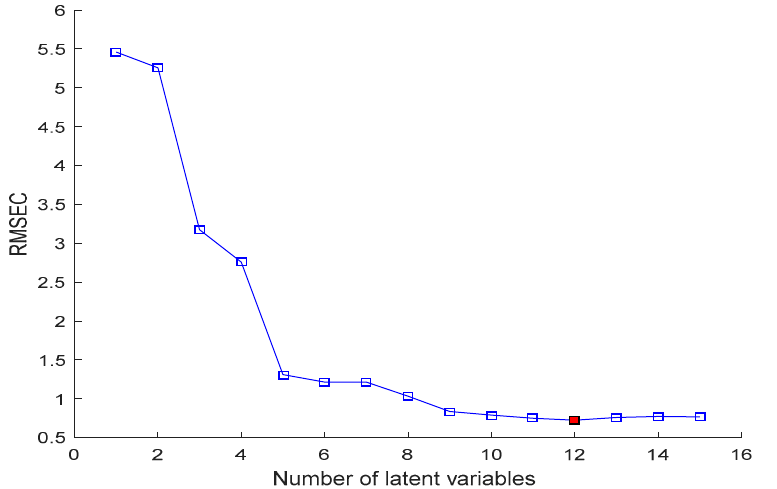
Figure 6. Changed RMSEC with increasing number of variables in SPA.